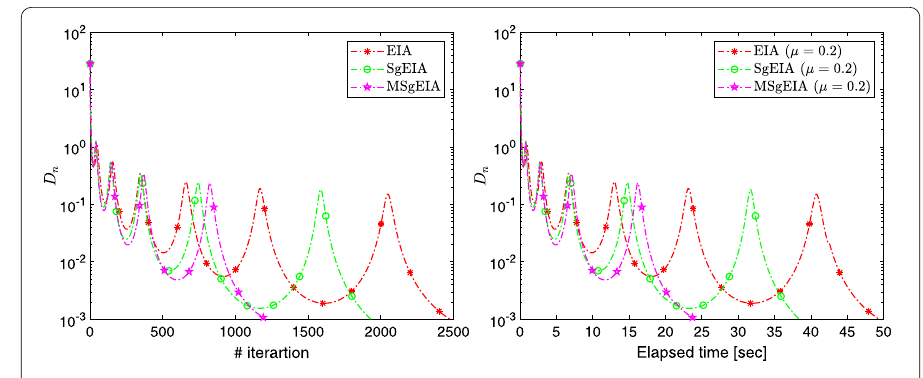
Figure 9 Algorithm 2 compared in terms of no. of iterations and elapsed time